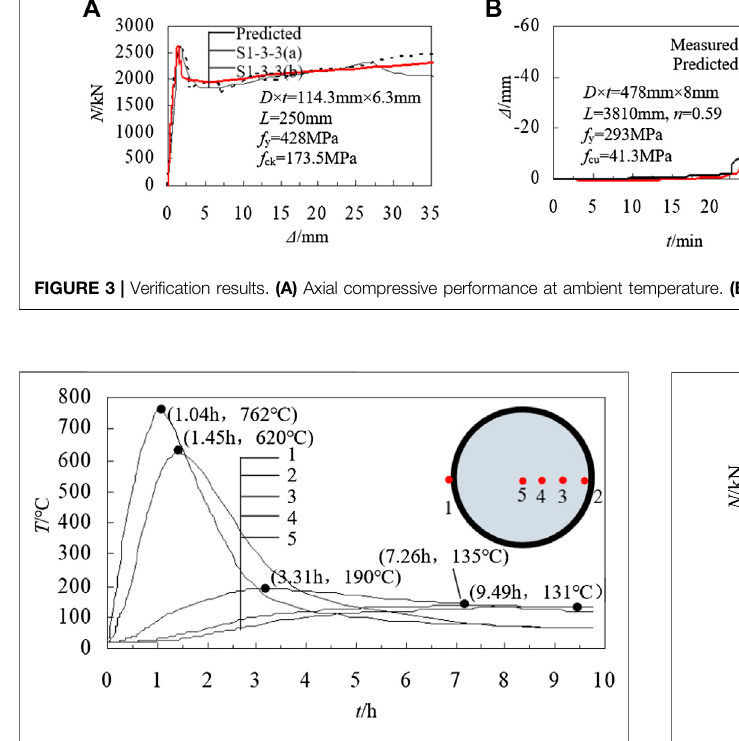
FIGURE 4 | T - t curve of middle section of high strength CFST. FIGURE 5 | N - Δ curve of specimen section.